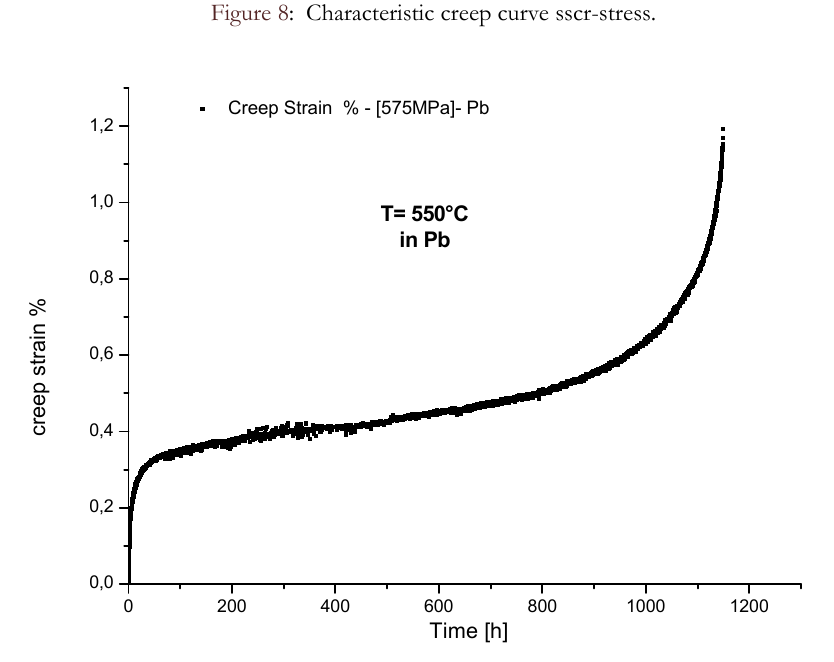
Figure 8: Characteristic creep curve sscr-stress.